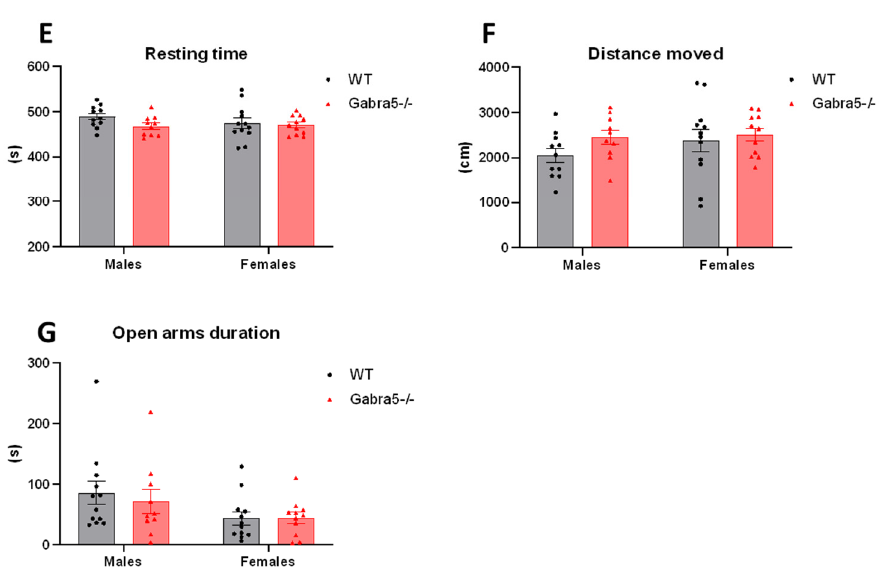
Figure 3. Open field and elevated plus maze tests. ( A – C ) OF anxiety-like test parameters; center duration, latency to enter center and number of center entries. ( D – F ) OF activity parameters; average speed, resting time and distance moved. ( G ) Elevated plus maze open arms duration. Two-way ANOVA main genotype effects all above p > 0.05. All figures are depicted with mean ± SEM, n = 12.